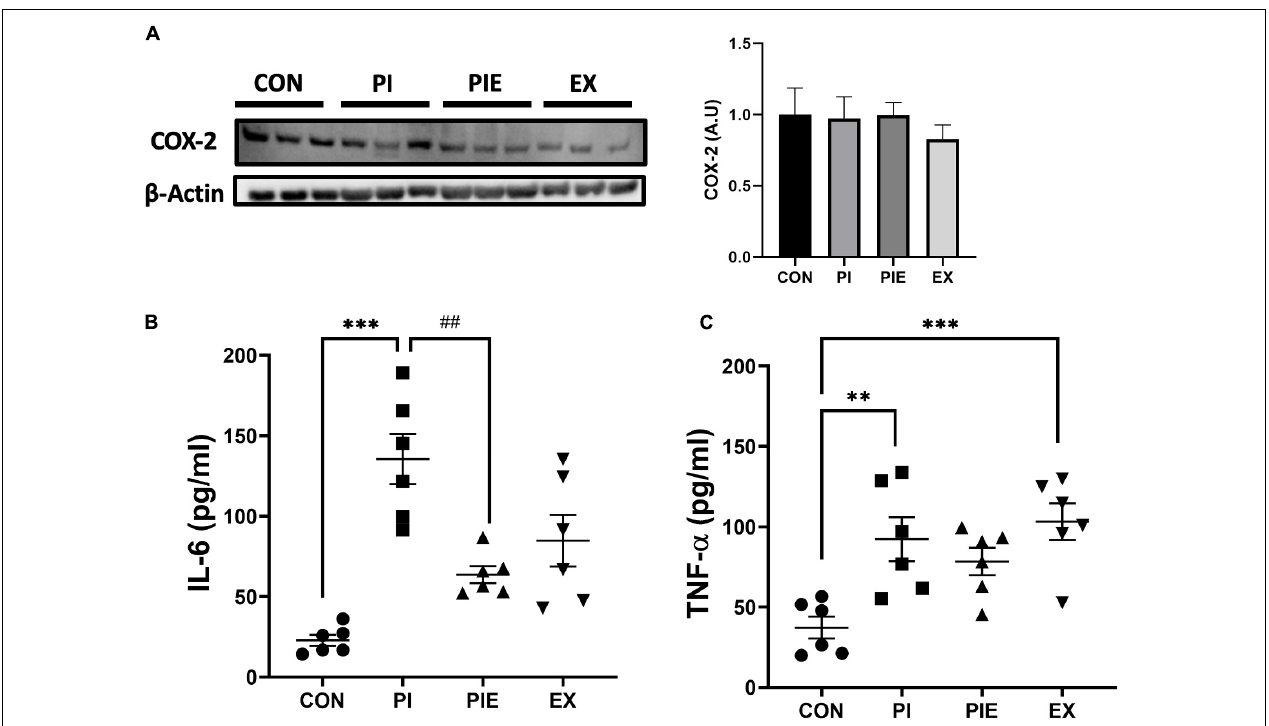
FIGURE 7 | Effect of PM and exercise on the expression of pro-inflammatory markers. (A) Representative western blot image of COX2 in the lung. Effect of 1 week of PM exposure and/or exercise on expression of IL-6 (B) and TNF- α (C) in the plasma. Levels were determined by ELISA assay. Values are the means ± SEM